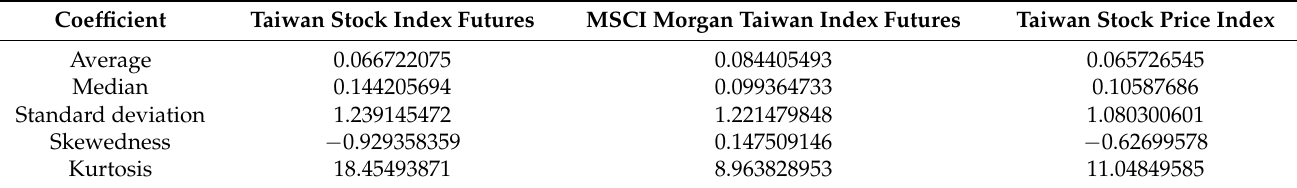
Table 1. Descriptive statistics of Case